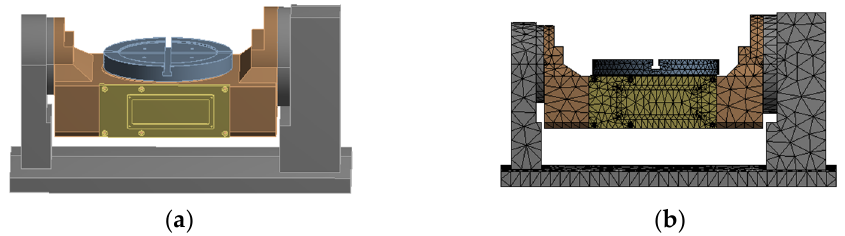
Figure 8. Three-dimensional model and meshing of the rotary system of the turntable; ( a ) Three- dimensional model drawing; ( b ) Grid model diagram.